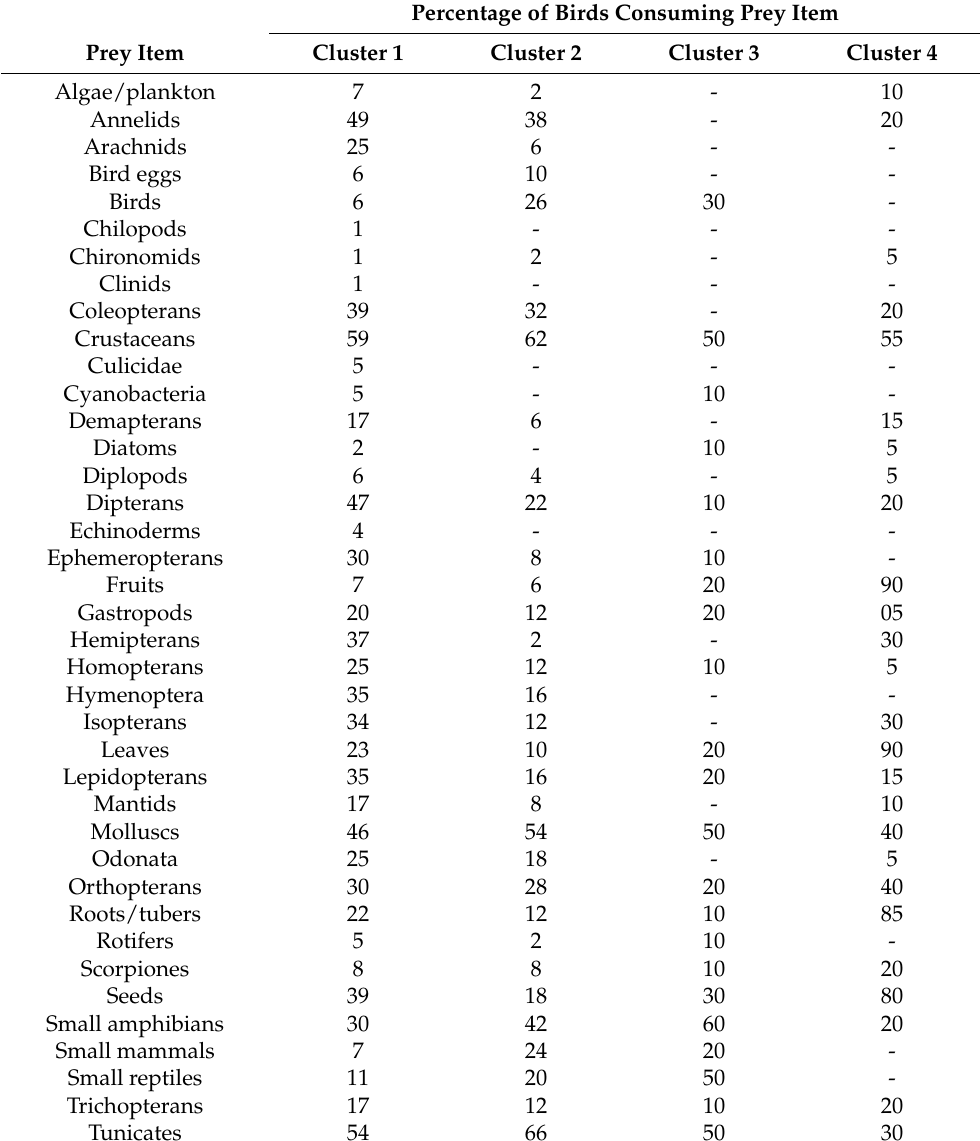
Table 2. Waterbird prey in southern Africa and their representation in the diets of waterbird